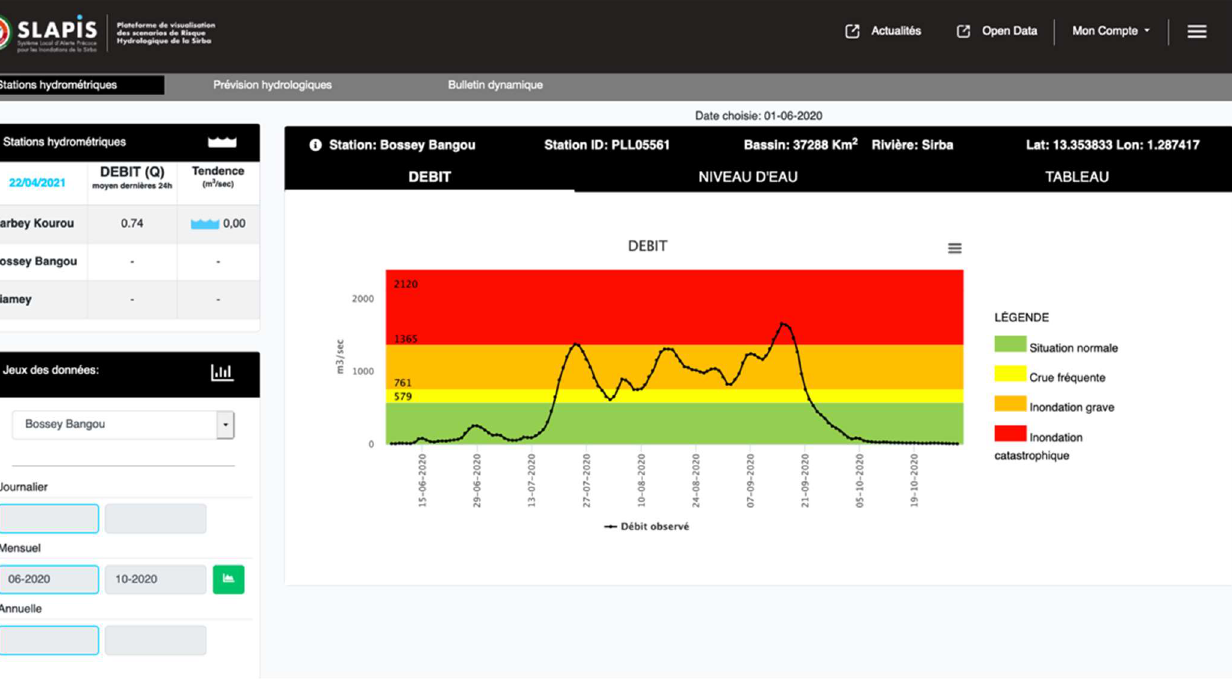
Figure 9. Private view of the web application: view of dataset analysis functions.